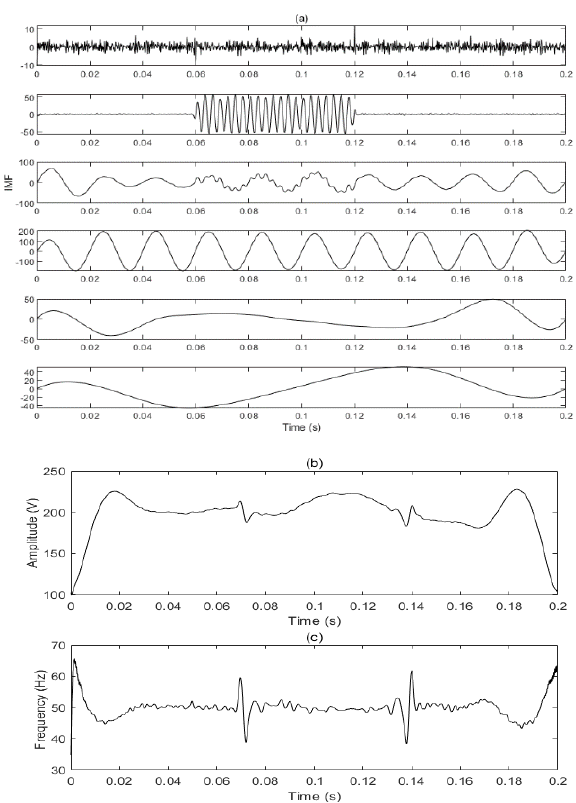
Figure 12. Oscillatory transient IMF components ( a ), amplitude ( b ), and frequency ( c ).